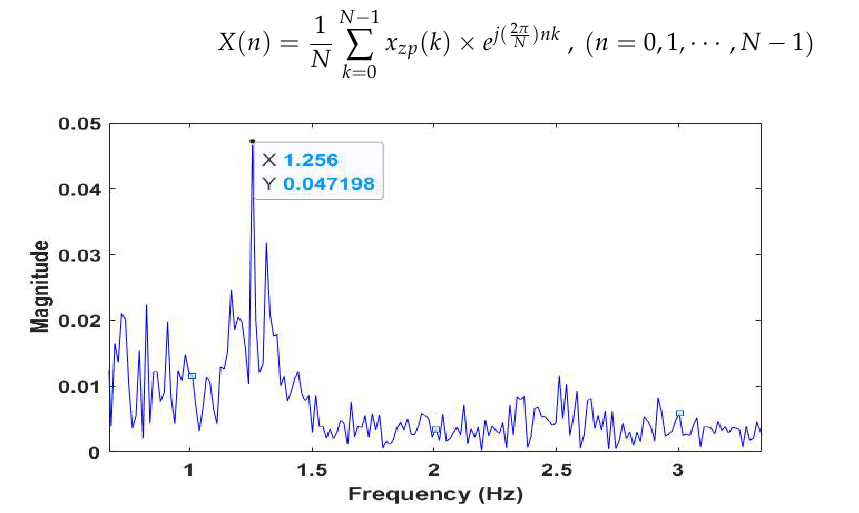
Figure 8. Frequency domain of the Cg signal (Figure 7).